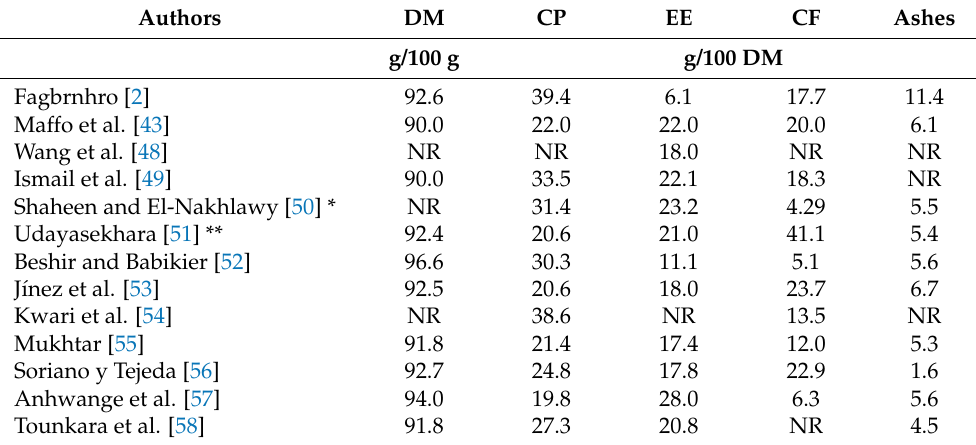
Table 1. Hibiscus sabdariffa L. chemical composition.